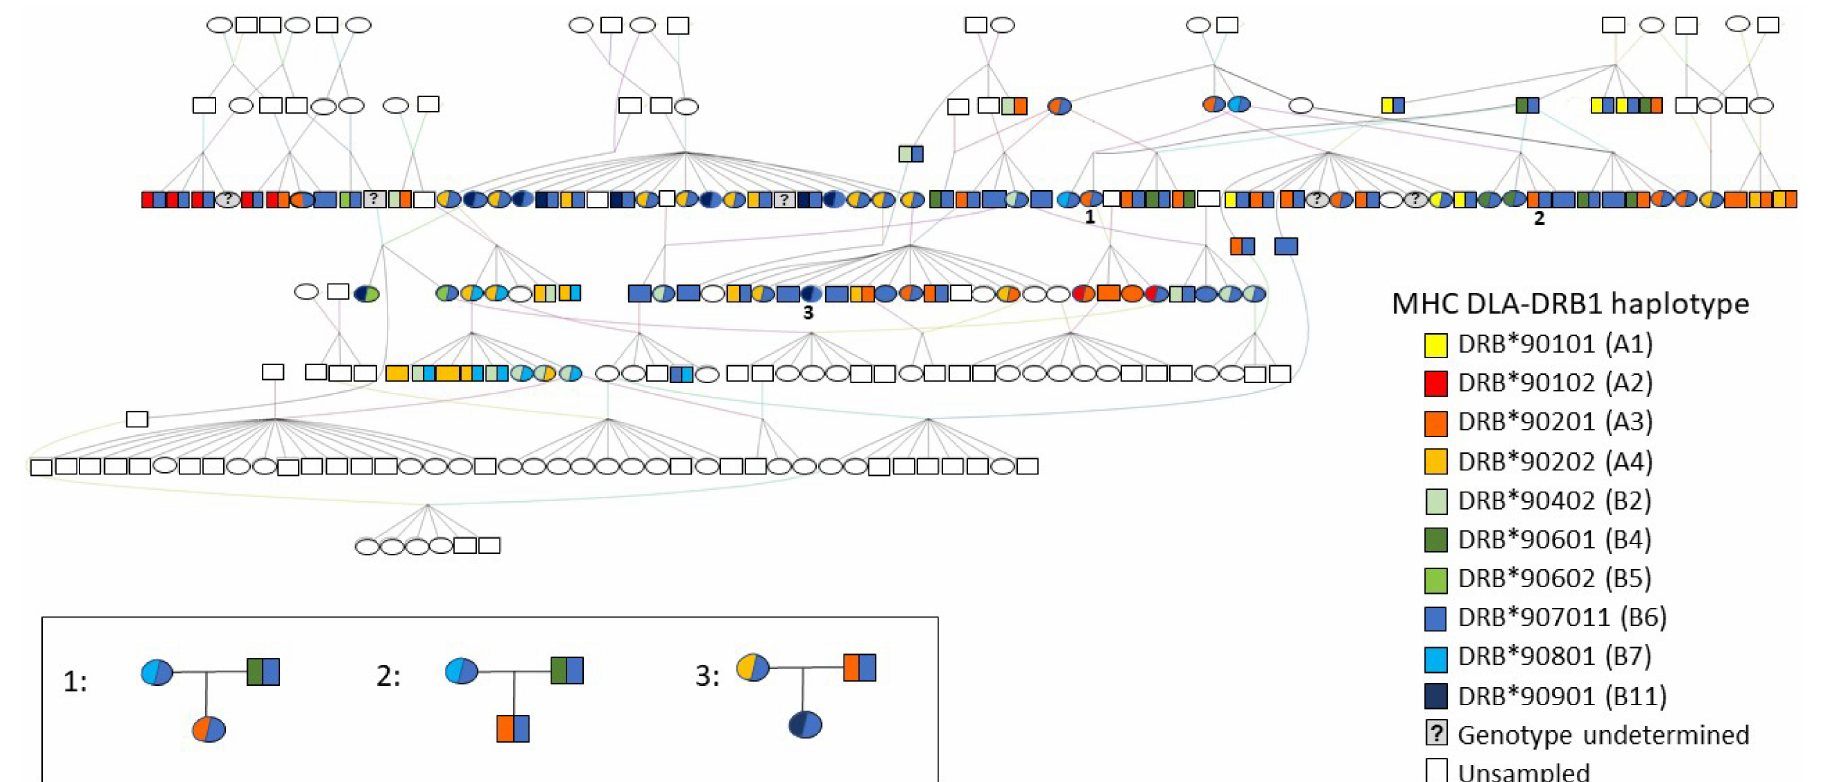
Figure 2. Pedigree of a subset of the NA population of APD, including sampled individuals ( n = 109), their parents, grandparents, and offspring. Squares represent males; ovals represent females. Colors indicate MHC DLA-DRB1 genotypes of sampled individuals; individuals with a single color are homozygous for the represented allele; those with two colors are heterozygous. Three cases are highlighted in the inset (numbered 1–3 on the pedigree), where the MHC genotypes of the offspring are inconsistent with those of the presumptive parents, indicating likely errors in the